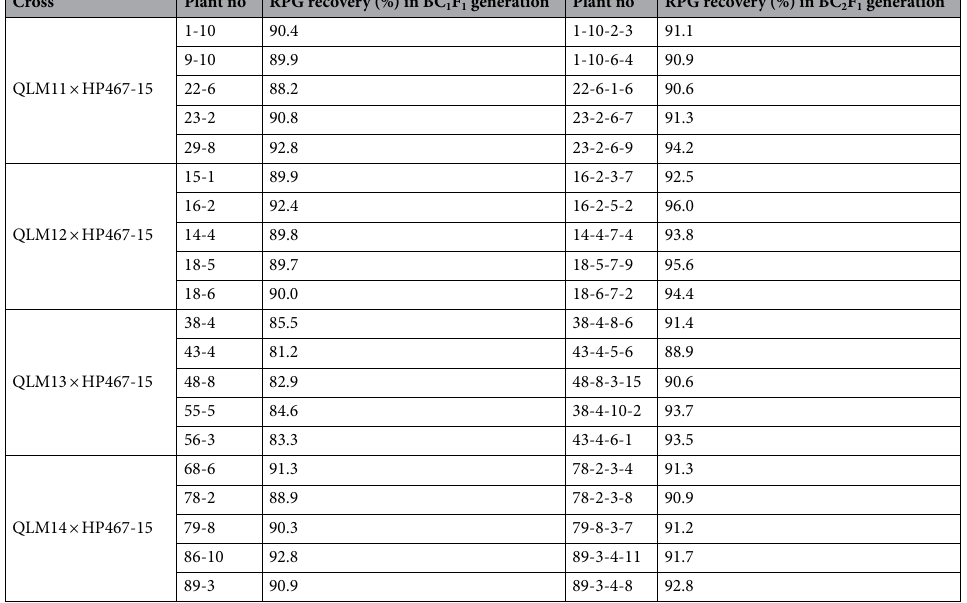
Table 2. Recovery of recurrent parent genome (%) in two backcross generations among the best five introgressed progenies of four crosses.